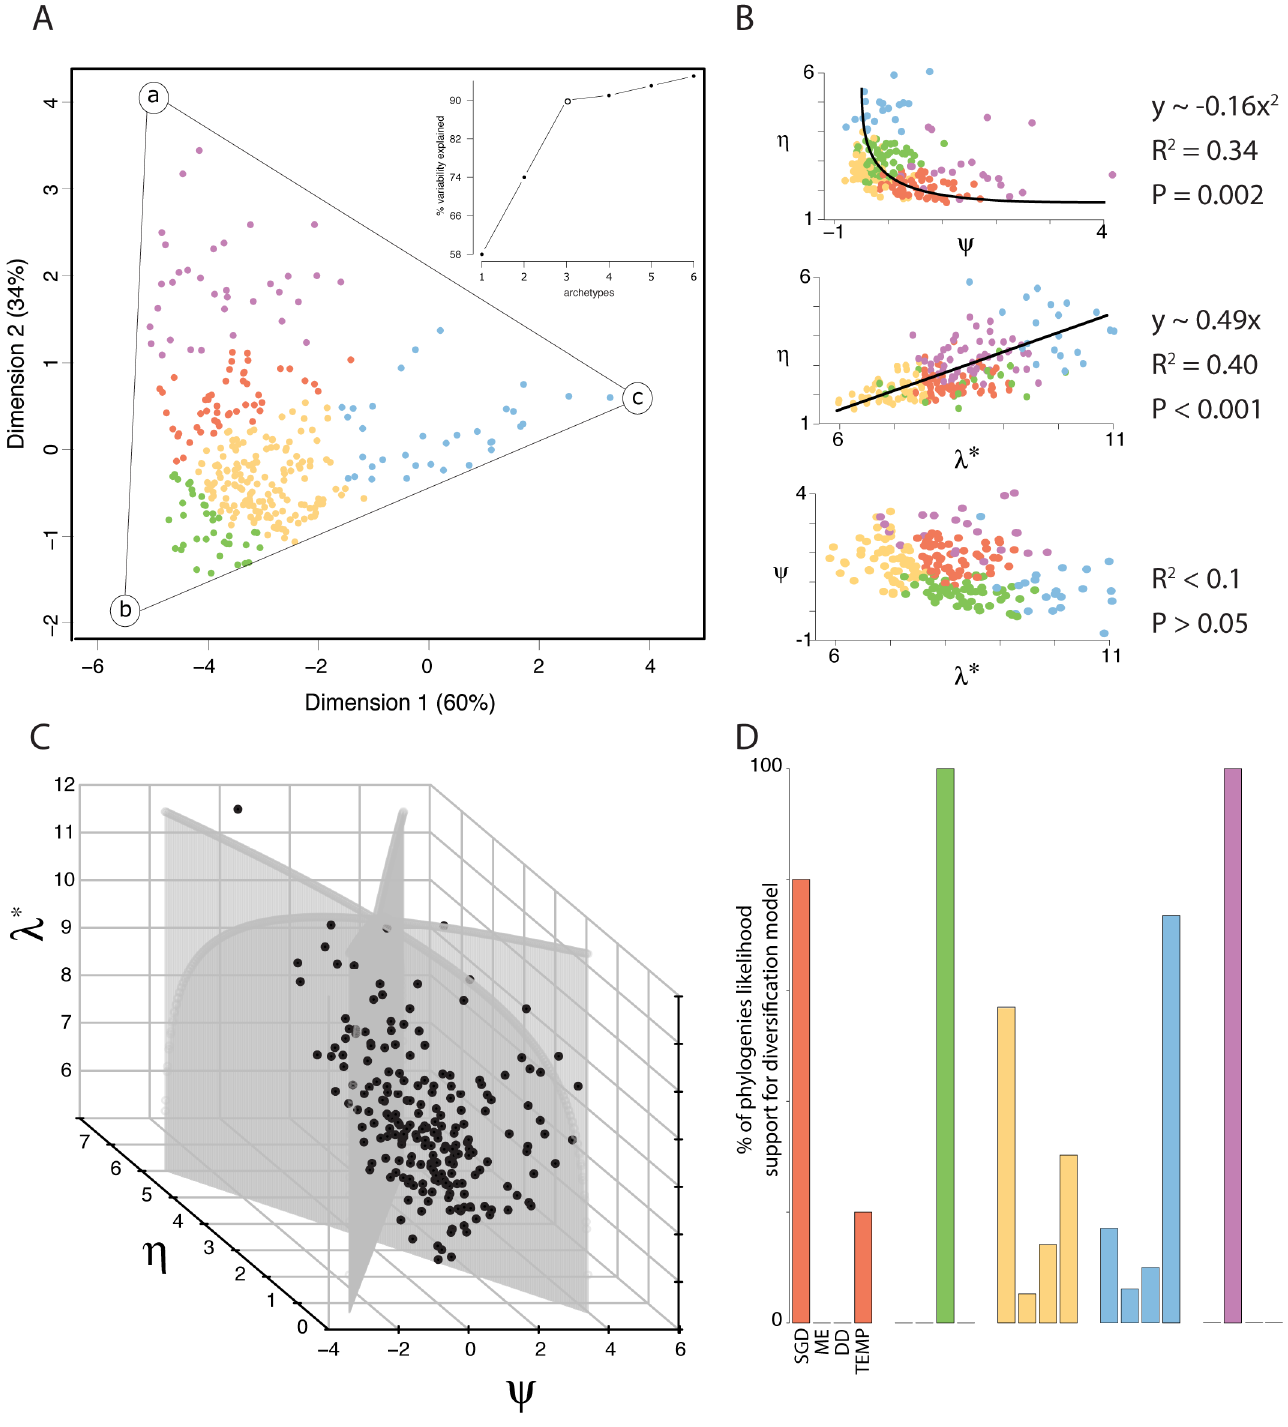
Fig 3. Constraints and trade-offs in vertebrate phylogenetic space. (A) The geometry of phylogenetic space (in Fig 2B) is best fit by a triangle, with each vertex corresponding to an archetype defind by a unique set of phylogenetic properties. (A, inset) The explained variability of the data distribution elbows at three vertices. (B) The trade-offs between phylogenetic properties in vertebrate phylogenetic space. (C) The set of empirical trees (black) and simulated phylogeny-type networks (grey) plotted in phylogenetic space. (D) Barplots of the percentage of empirical phylogenies of each diversification type with maximum likelihood support from a particular diversification model. Points in (A) are colored according to Fig 1. See S1 Data for summary statistic and model AICc values and S4 Data for model percentages.